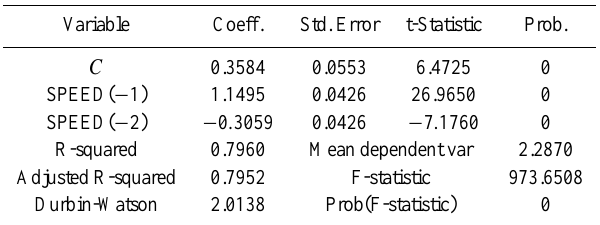
Table 2. Statistical coefficient of wind speed time series model.